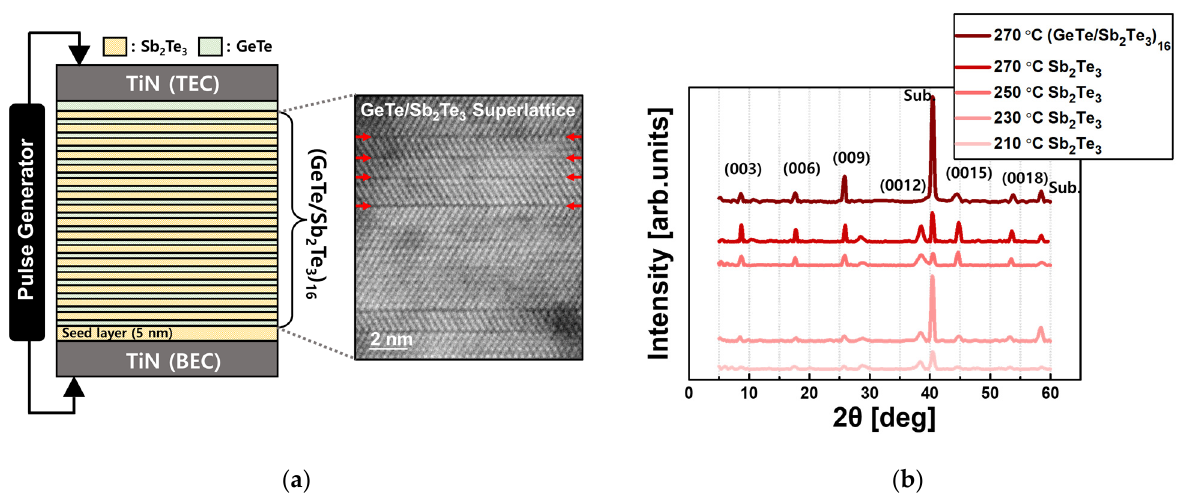
Figure 1. ( a ) Schematic of (GeTe/Sb 2 Te 3 ) 16 iPCM and high-resolution TEM image of a typical (GeTe/Sb 2 Te 3 ) n material on silicon. The red arrow indicates the vdW gap between the thin films. ( b ) XRD peaks for each (00 l ) plane of the grown Sb 2 Te 3 films and (GeTe/Sb 2 Te 3 ) 16 interfacial materials fabricated with different annealing temperatures.